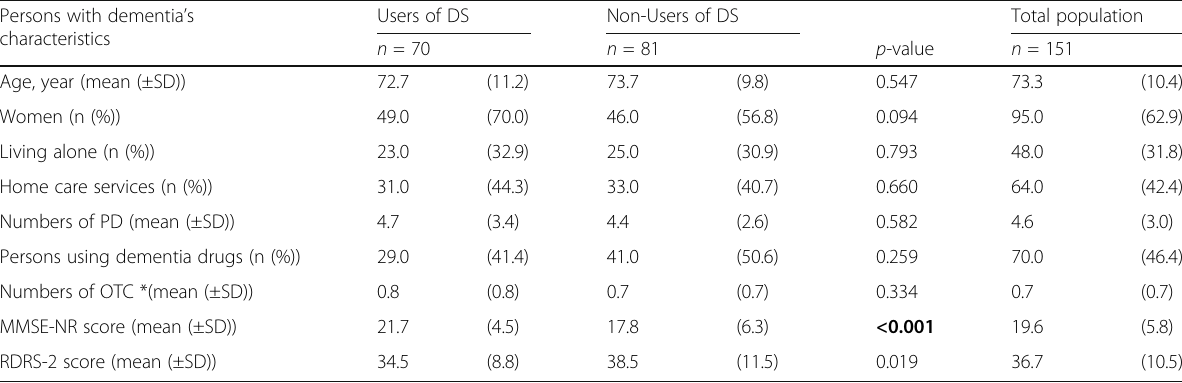
Table 1 Comparison between users and non-users of dietary supplements Persons with dementia ’ s